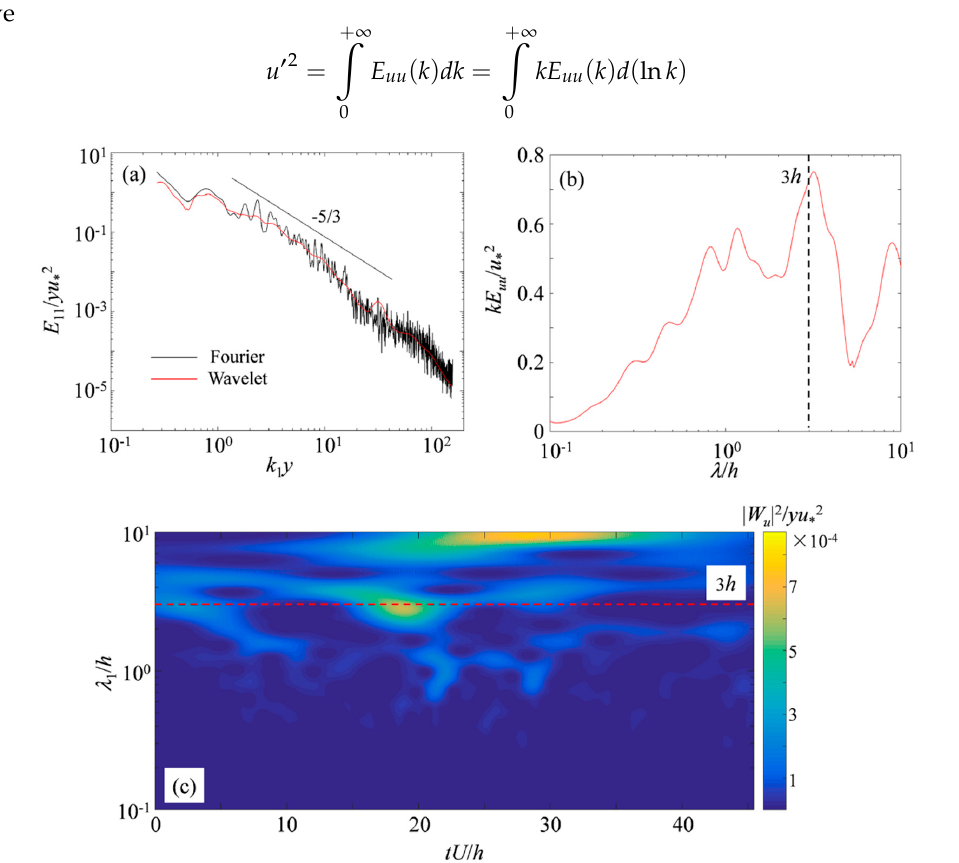
Figure 1. The wavenumber spectrum ( a ), pre-multiplied spectrum ( b ) and local wavelet spectrum ( c ) of the streamwise velocity series at the measurement point ( x / h = 0, y / h = 0.5). The black solid straight line in ( a ) shows the classical − 5 / 3 law in the turbulence. The black dash line in ( b ) and red dash line in ( c ) is marked the strongest scale in the spectrum.